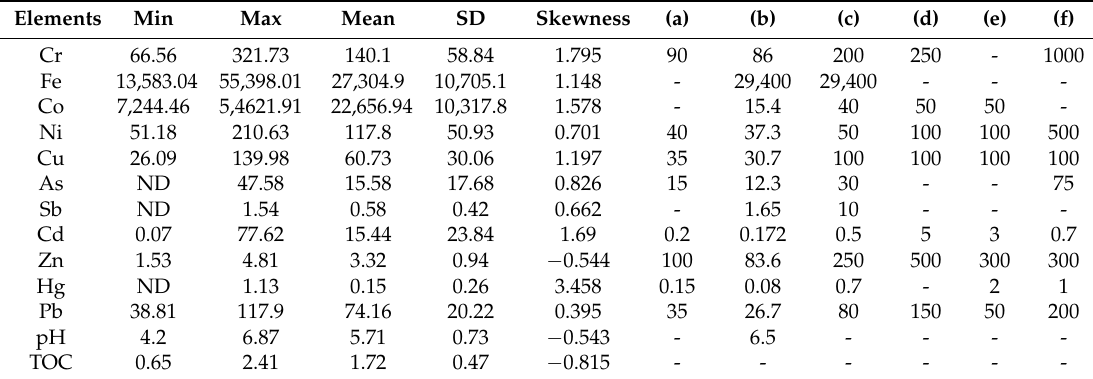
Table 2. Descriptive statistics of trace elements (mg/kg) and selected soil properties (pH and TOC) of soil from Huangpi district and background value of Wuhan, Hubei and China. Elements